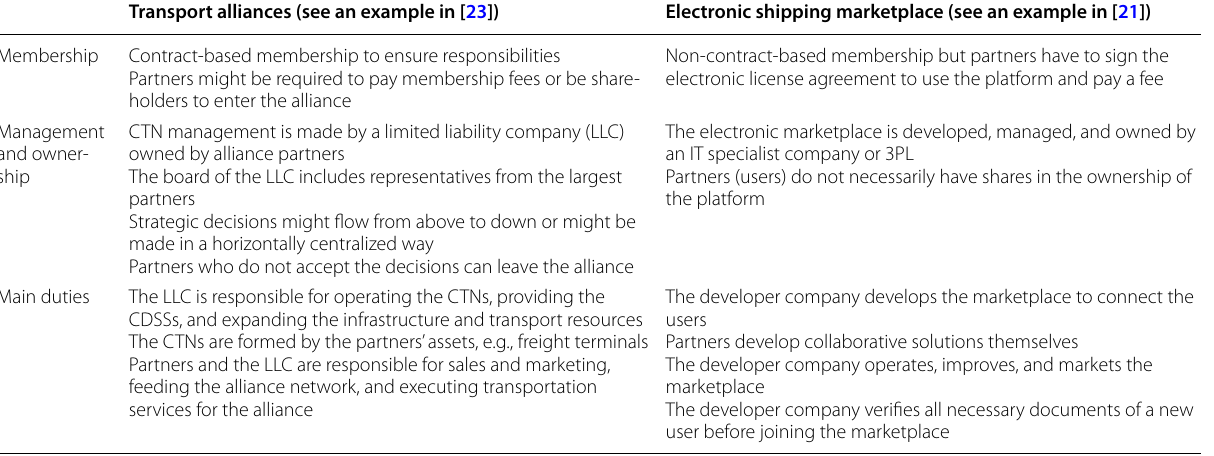
Table 1 Comparison of organizational setups among alliances, and E-marketplace platforms Transport alliances (see an example in